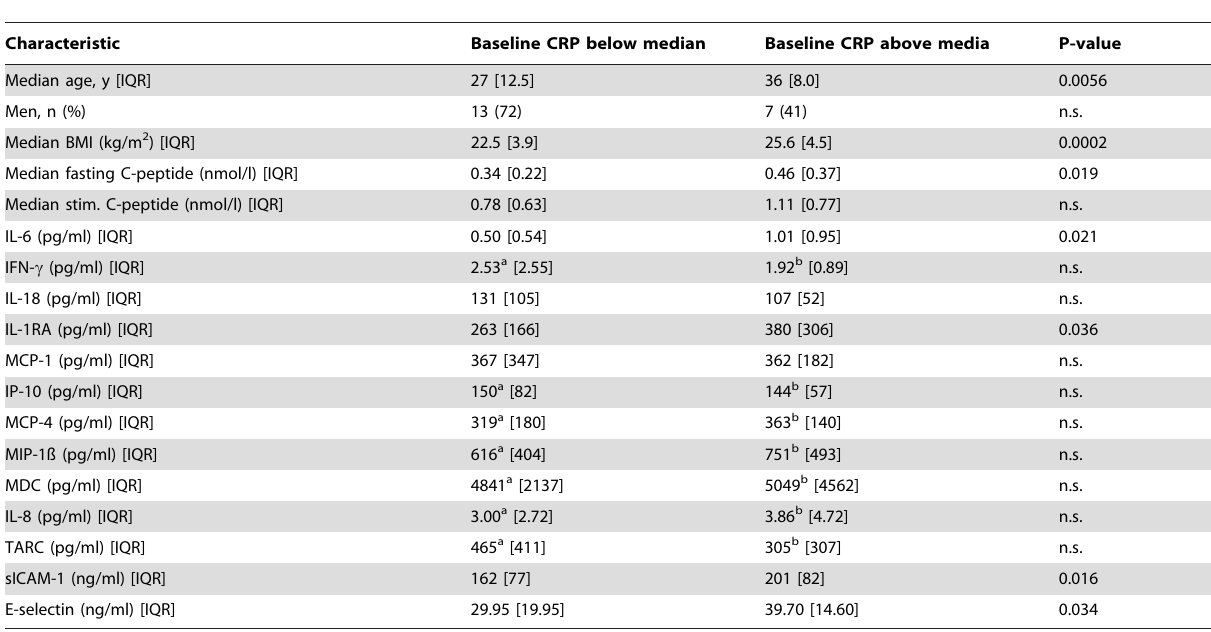
a Data available for 15 of 18 patients. b Data available for 15 of 17 patients. Subgroups were compared for single characteristics without adjustments for differences in other characteristics, in order to describe all differences observed.